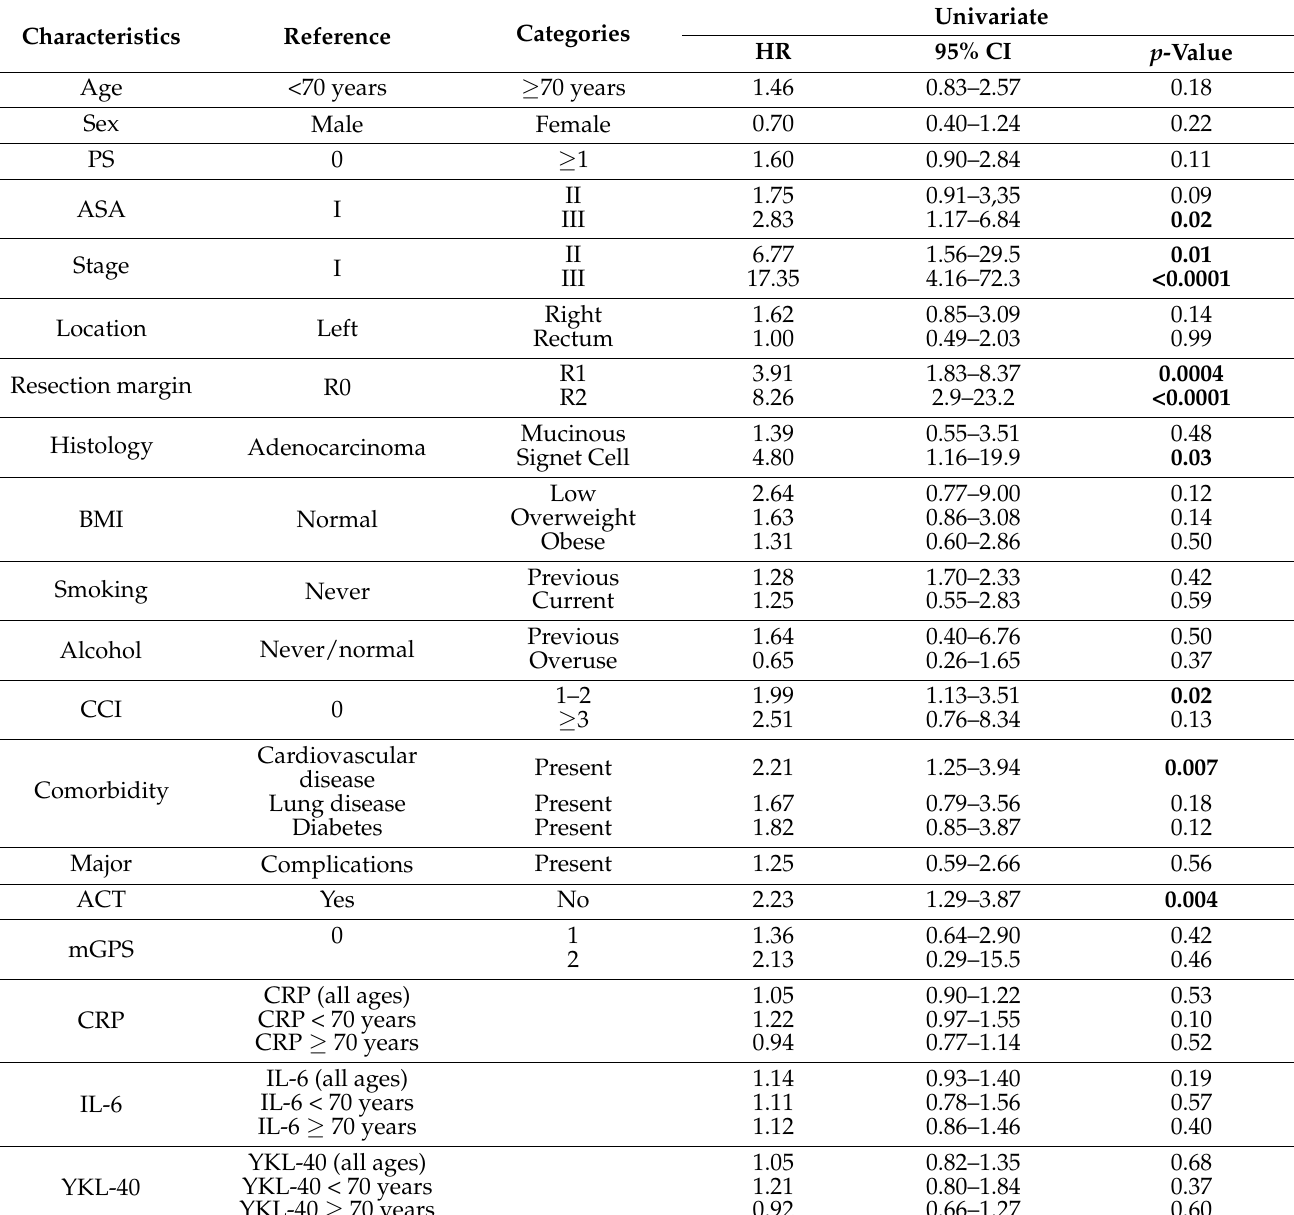
Table 6. Univariate analysis of clinical characteristics and biomarkers’ association with disease